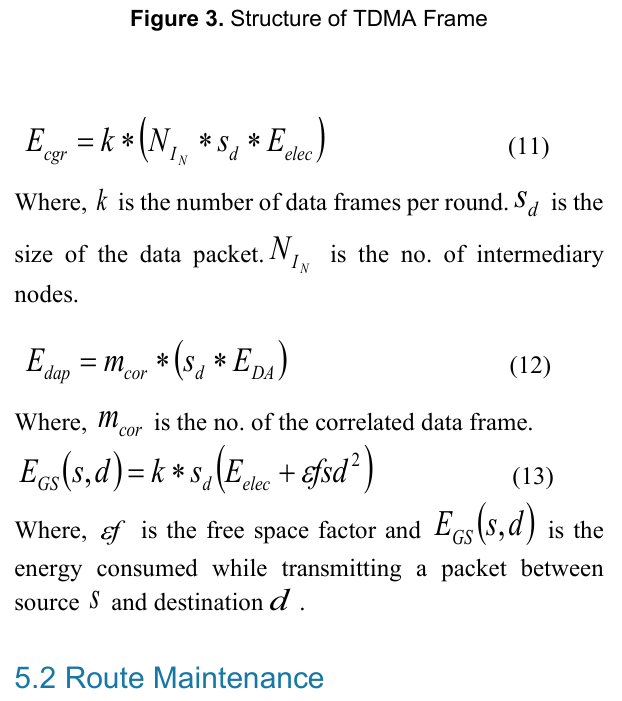
Figure 3. Structure of TDMA